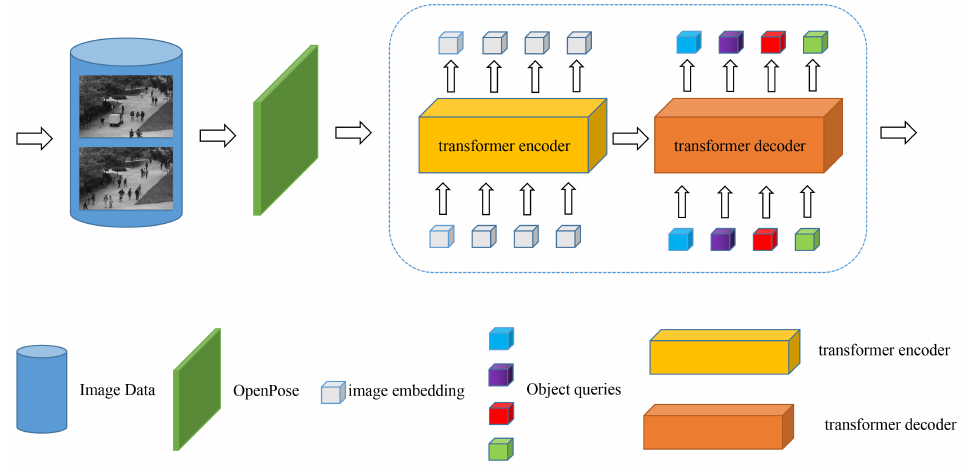
Figure 7. Structure of the improved